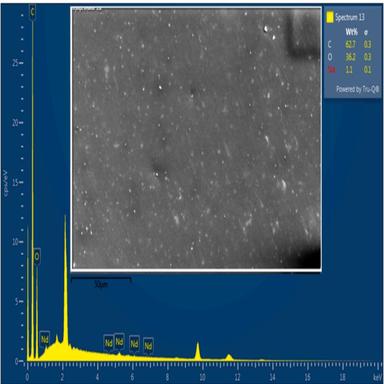
EDX of the composite PVA/Nd2O3.